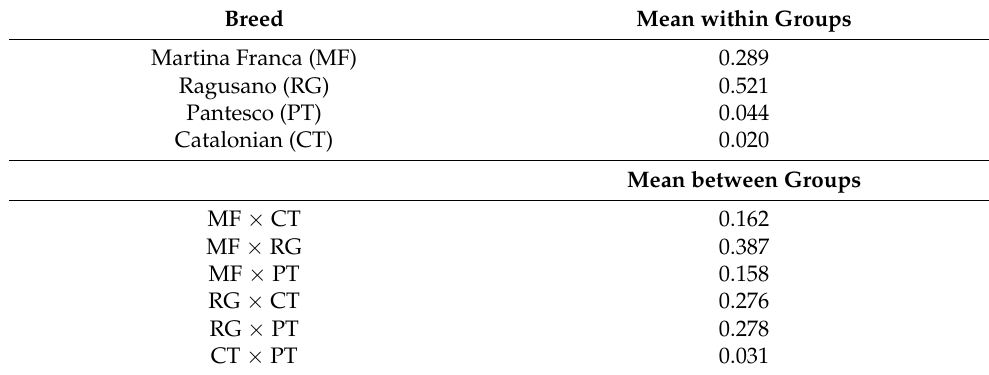
Table 3. Estimates of base composition differences within and between breed sequences using